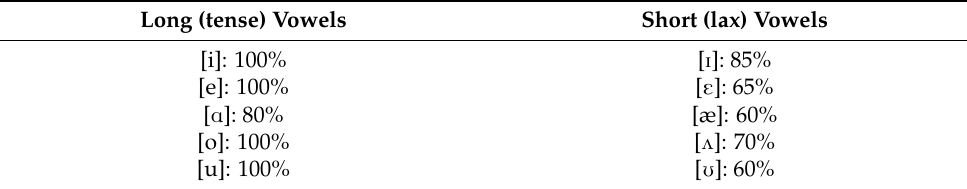
Table 5. Perceptual accuracy of Mandarin listeners to English